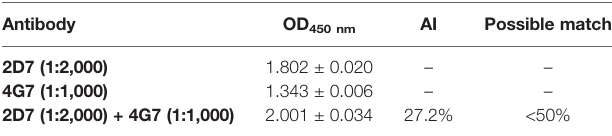
TABLE 2 | Results of ELISA additivity